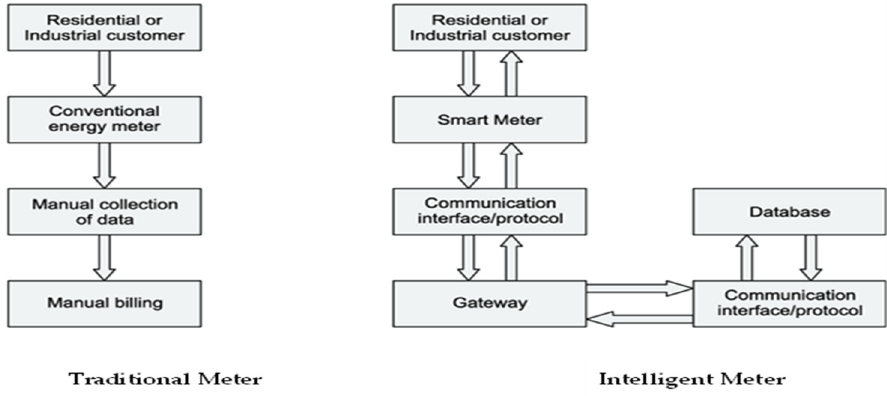
Figure 6. Traditional meter vs. intelligent meter architecture comparison.